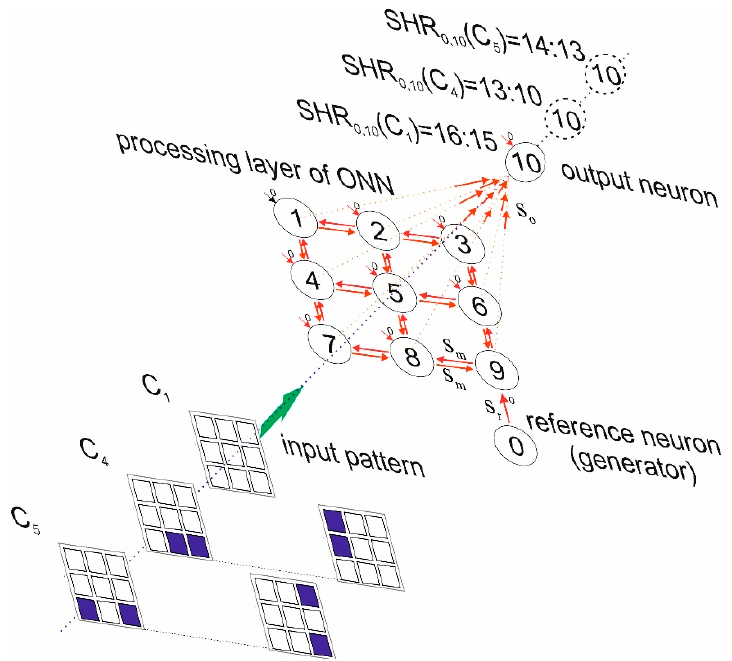
Figure 11. The principle of class recognition of neural network figures with one output neuron.